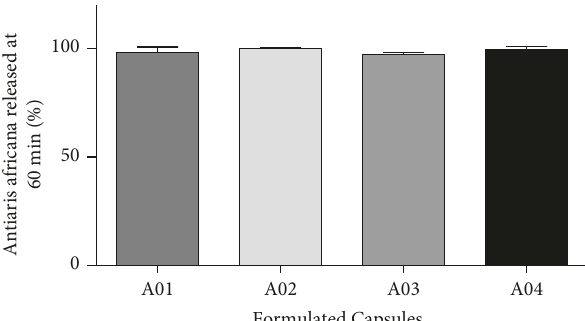
Figure 5: Percentage release of Antiaris africana extract from A01, A02, A03, and A04 capsules (mean ± SD, n � 3). Table 6: Similarity factor ( f2 ) and difference factor ( f1 ) between formulated capsules and Antiaris decoction. Formulation code Similarity factor ( f2